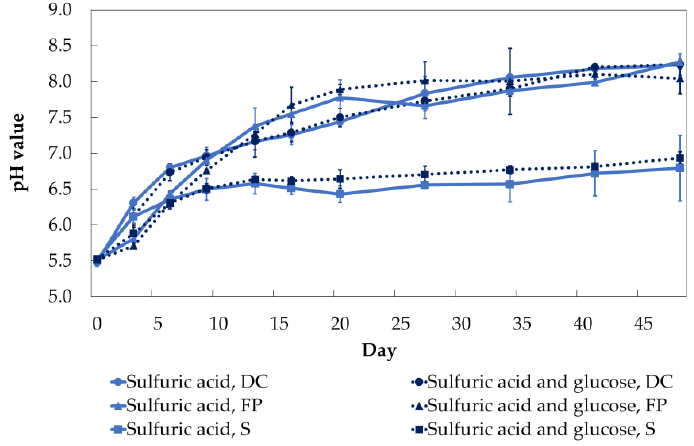
Figure 4. The pH value of dairy cow (DC, ●), fattening pig (FP, ▲ ), and sow (S, ■ ) slurry after acidification with sulfuric acid or in combination with glucose addition (0.01 mol glucose kg − 1 slurry) to a pH value of 5.5 during the storage period of 48 days (means ± SD, n = 3).